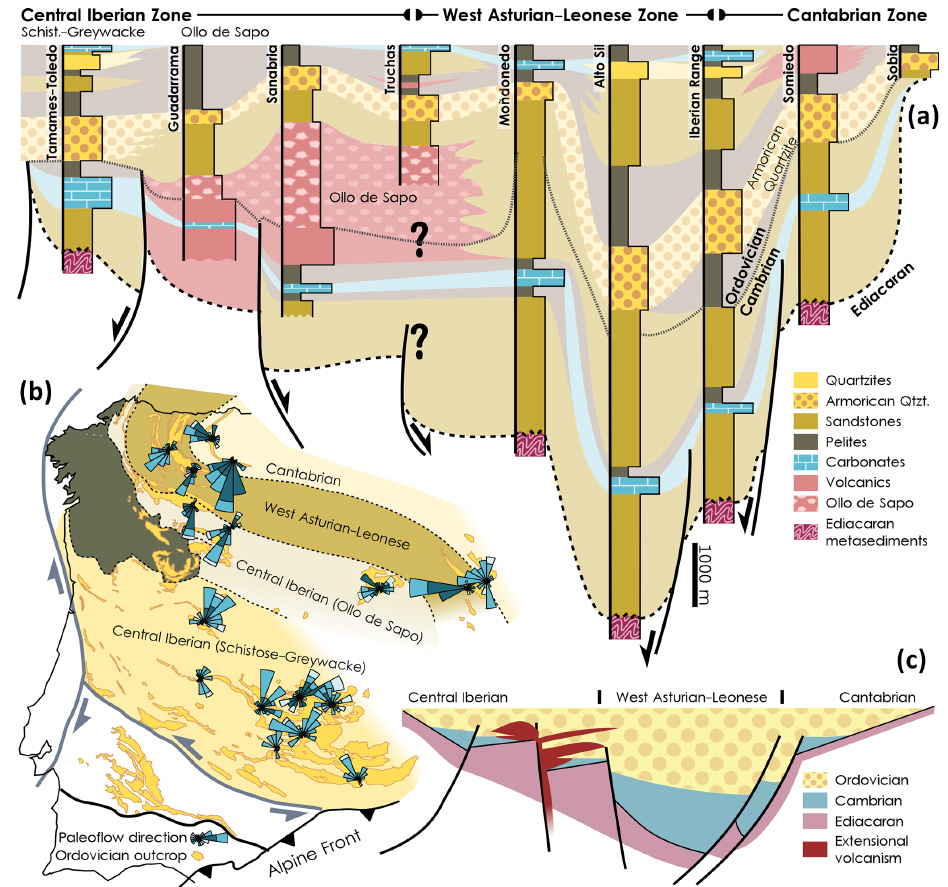
Figure 3. (a) Stratigraphic synthesis of the Gondwanan platform series in northwestern Iberia. Cantabrian Zone columns are based on Aramburu et al. (2002), Bastida (2004), Murphy et al. (2008), and Pastor-Galán et al. (2013a, b). Iberian Range is based on Gozalo et al. (2008), Mergl and Zamora (2012), and Calvín-Ballester and Casas (2014). West Asturian–Leonese Zone stratigraphy is based on Pérez- Estaún et al. (1990), Marcos et al. (2004), Martínez Catalán et al. (2004a), and Gutiérrez-Marco et al. (2019). Central Iberian Zone is based on Díez Balda (1986), Valladares et al. (2000), Montes (2007), Martínez Catalán et al. (2004b), del Moral and Sarmiento (2008), and García- Arias et al. (2018). (b) Ordovician paleocurrent orientations are modified from Shaw et al. (2012). (c) Schematic basin architecture inferred from the stratigraphic